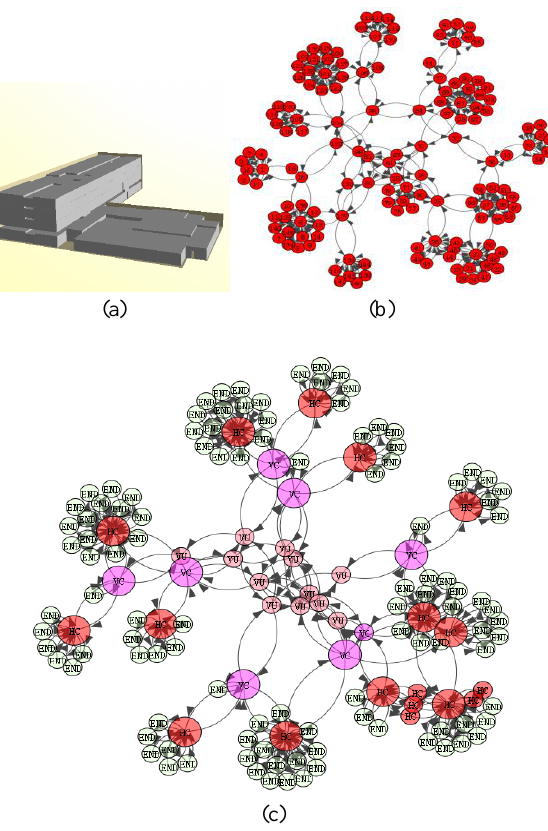
Figure 5: (a) The test building; (b) general connectivity network; (c) connectivity network enriched with INSM